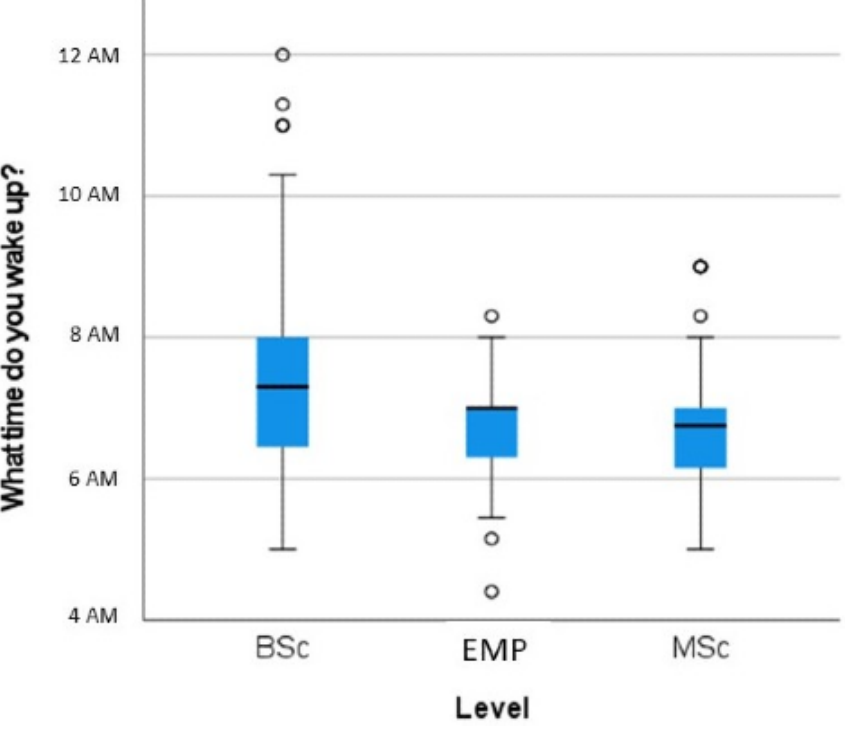
Figure 5. Box plots of wake-up time of students and employees (n=796) from the Bern University of Applied Sciences, Department of Health Professions during the spring 2020 COVID-19 lockdown. Whiskers indicate 1.5 × IQR unless truncated at the lowest score. Circles represent values outside this range. BSc: Bachelor of Science students; EMP: employees; MSc: Master of Science